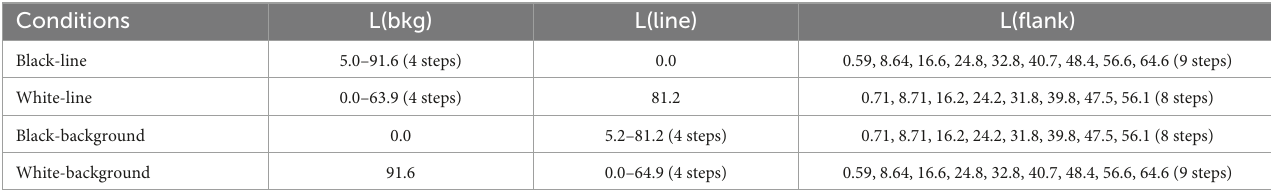
TABLE 1 Luminance conditions in Experiment